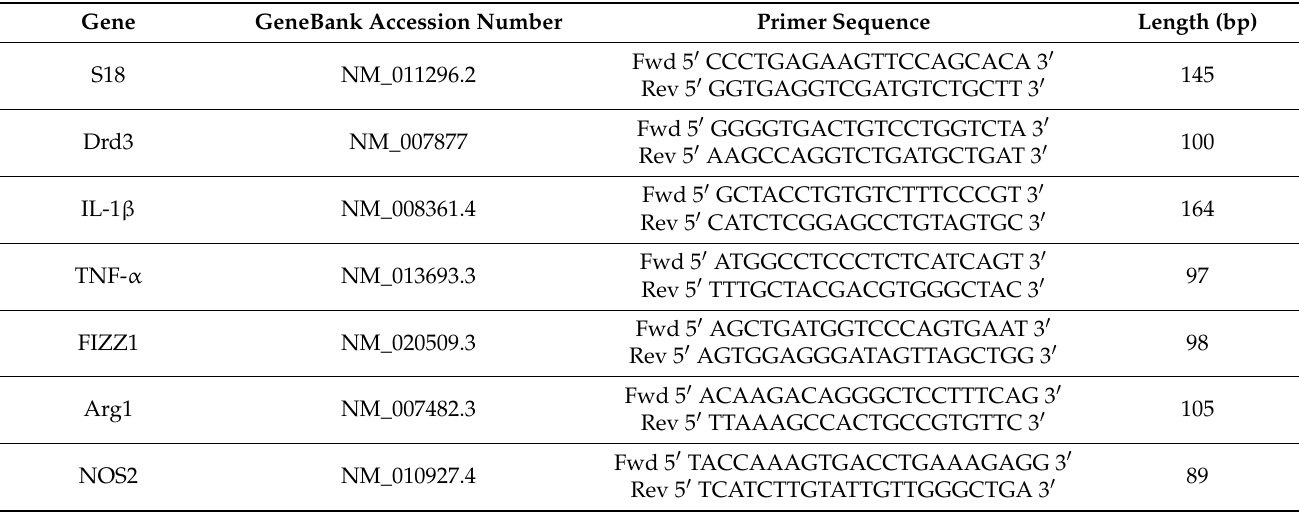
Table 4. List of primers sets used in real-time quantitative PCR